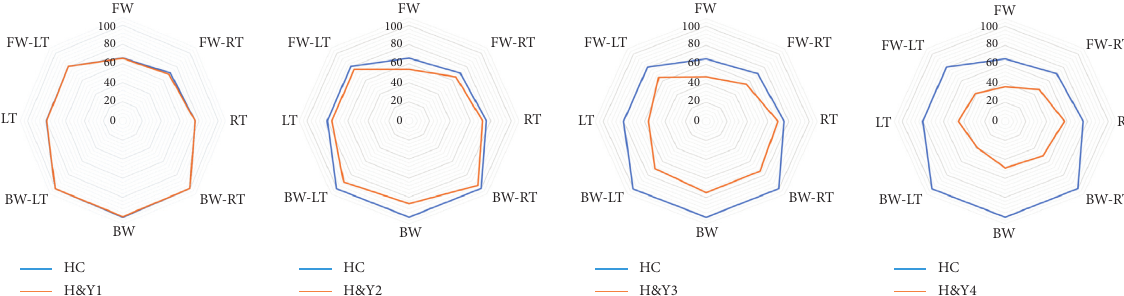
Figure 1: Directional analysis of limit of stability. H& Y � Hoehn–Yahr stage, HC � healthy control, FW � forward, BW � backward, RT � right, LT � left, FW-RT � forward-right, FW � forward-left, BWRT � backward-right, BW-LT � backward-left. ∗ p < 0 . 05, ∗ ∗ p < 0 . 01.